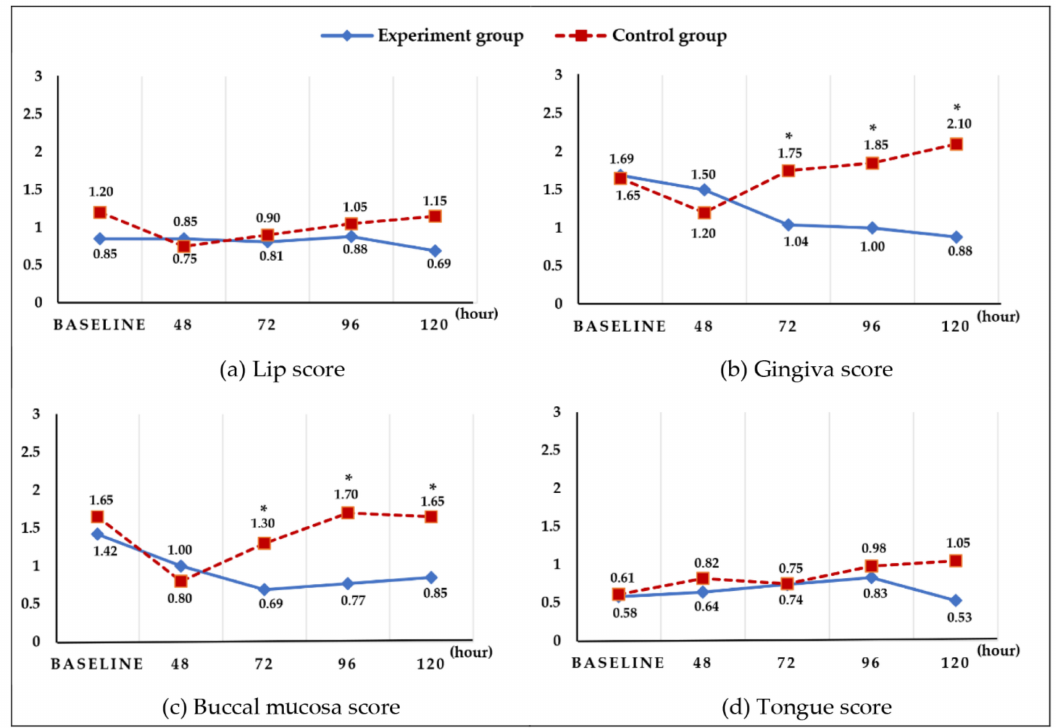
Figure 3. Changes in the oral area (soft tissue) score. There were no significant differences in lips and tongue, but significant differences were observed between groups in gingiva and buccal mucosa at 72, 96, and 120 h (an independent t -test was conducted at each time point, Bonferroni correction * p <